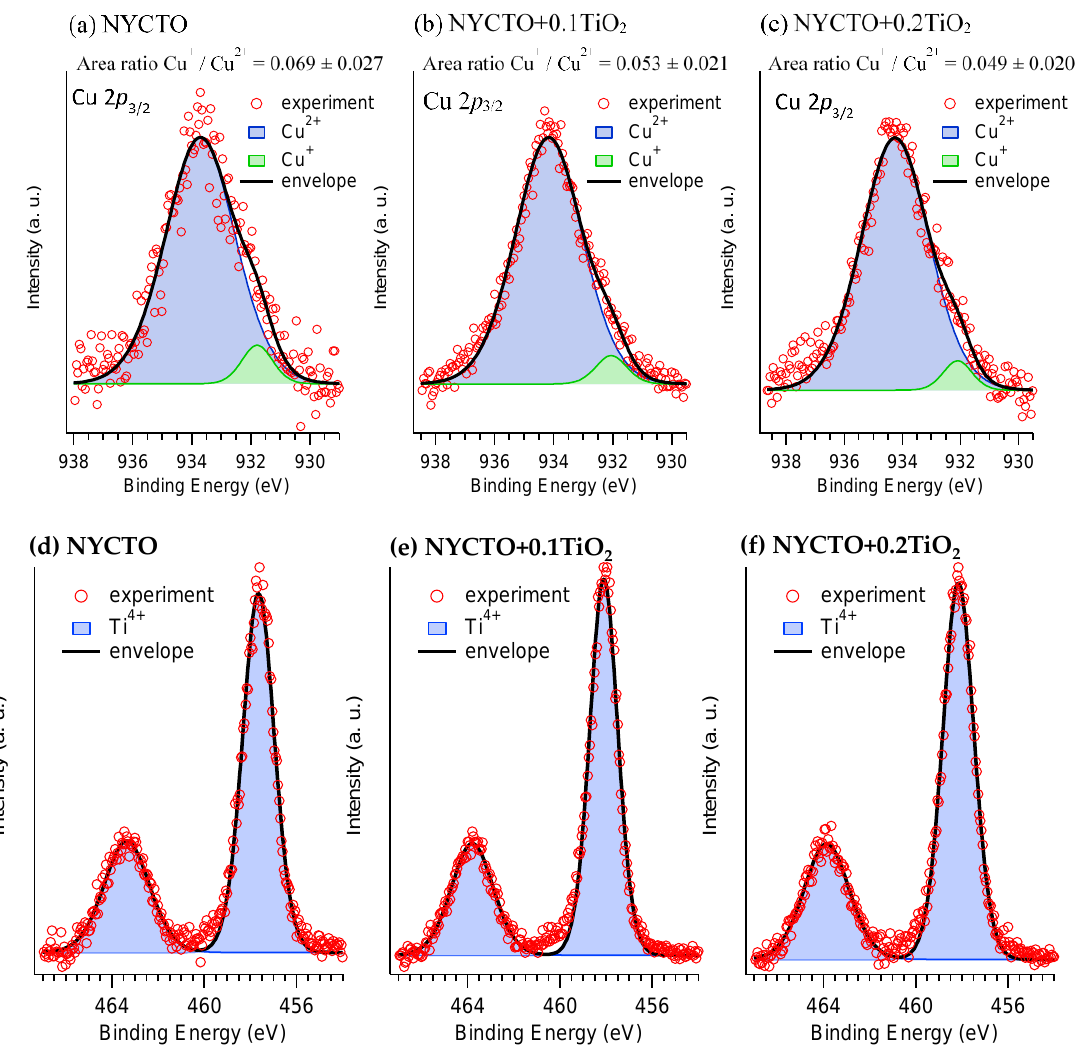
Figure 11. ( a – c ) XPS spectra of Cu 2 p 3/2 for all sintered NYCTO + xTiO 2 ceramics. ( d – f ) XPS spectra of Ti 2 p for all sintered NYCTO + xTiO 2 ceramics.